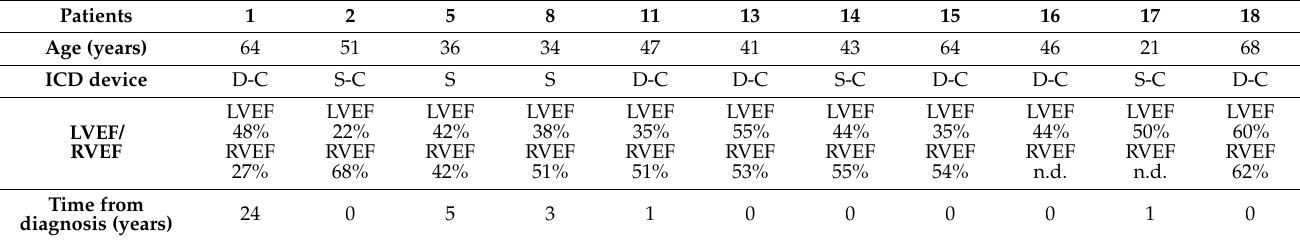
LVEF: Left Ventricle Ejection Fraction; RVEF: Right Ventricle Ejection Fraction. D-C: Dual-Chamber; S-C: Single- Chamber; S: Subcutaneous.